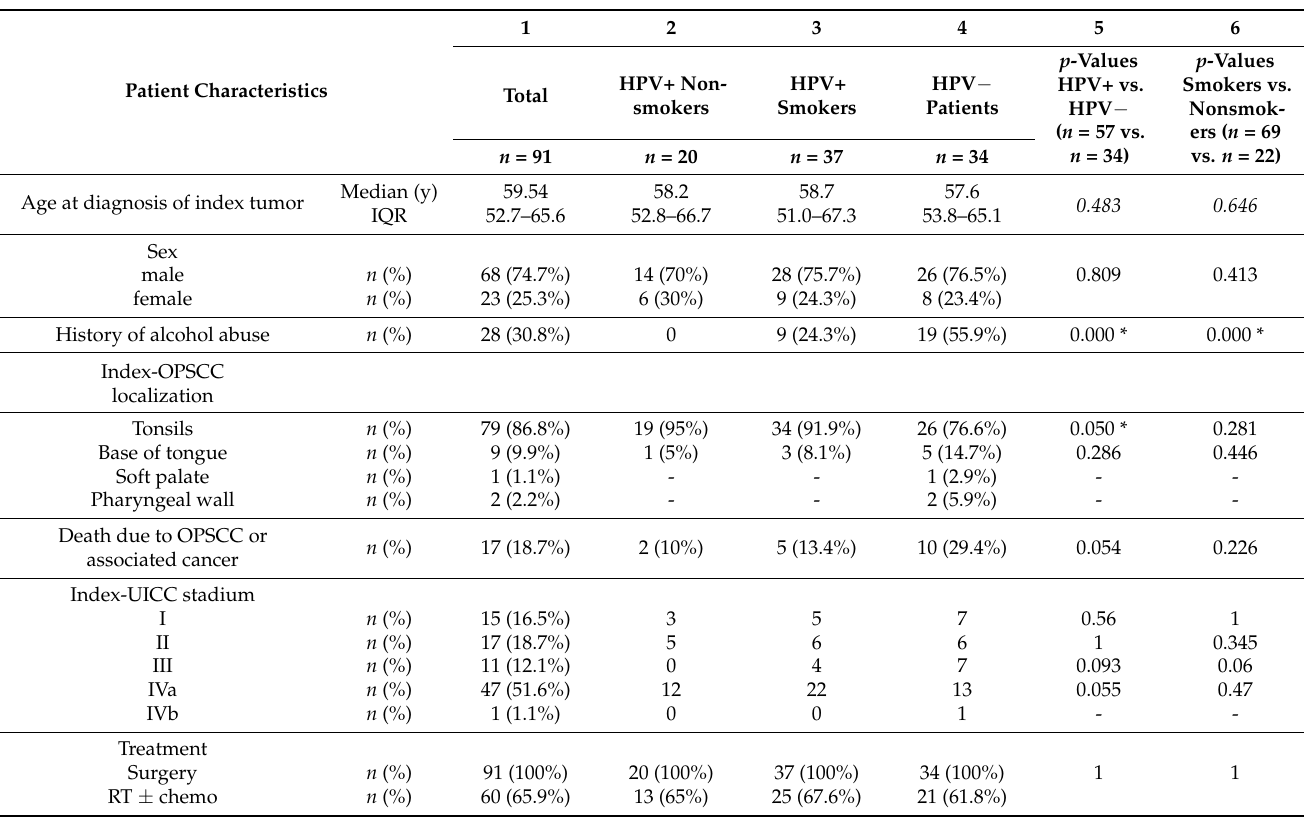
Table 1. Patient characteristics. The p -values related to age are calculated by T-test (columns 5 and 6, marked in italics). The other group comparisons of columns 5 and 6 were performed with two-sided Fisher’s exact test. Values statistically significant at the 5% significance level are marked with *. Abbreviations: − = negative, + = positive, chemo = chemotherapy, IQR = interquartile range, RT =